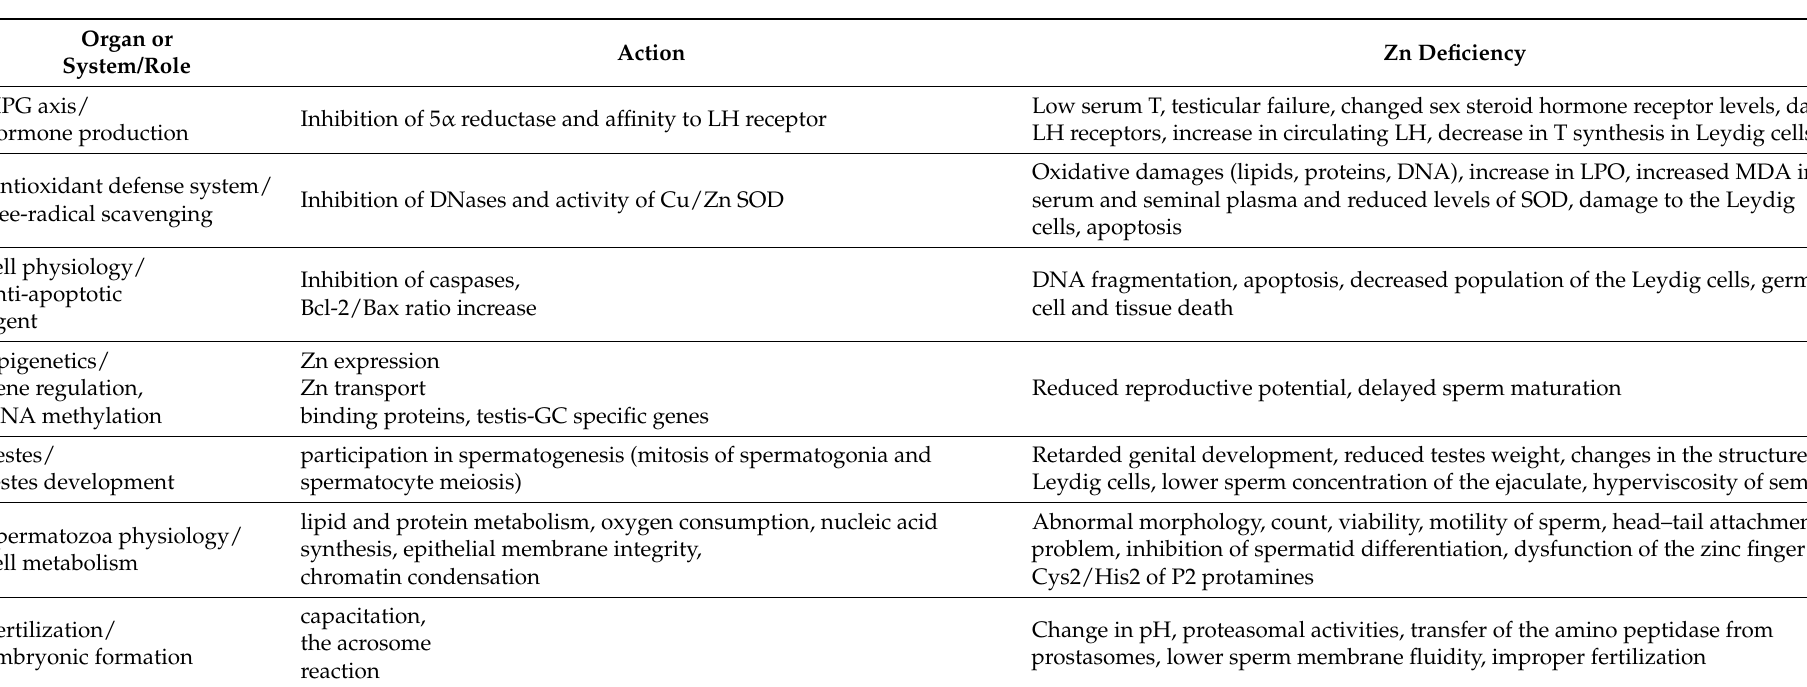
Table 2. The role of Zn in male fertility and the effects of deficiency